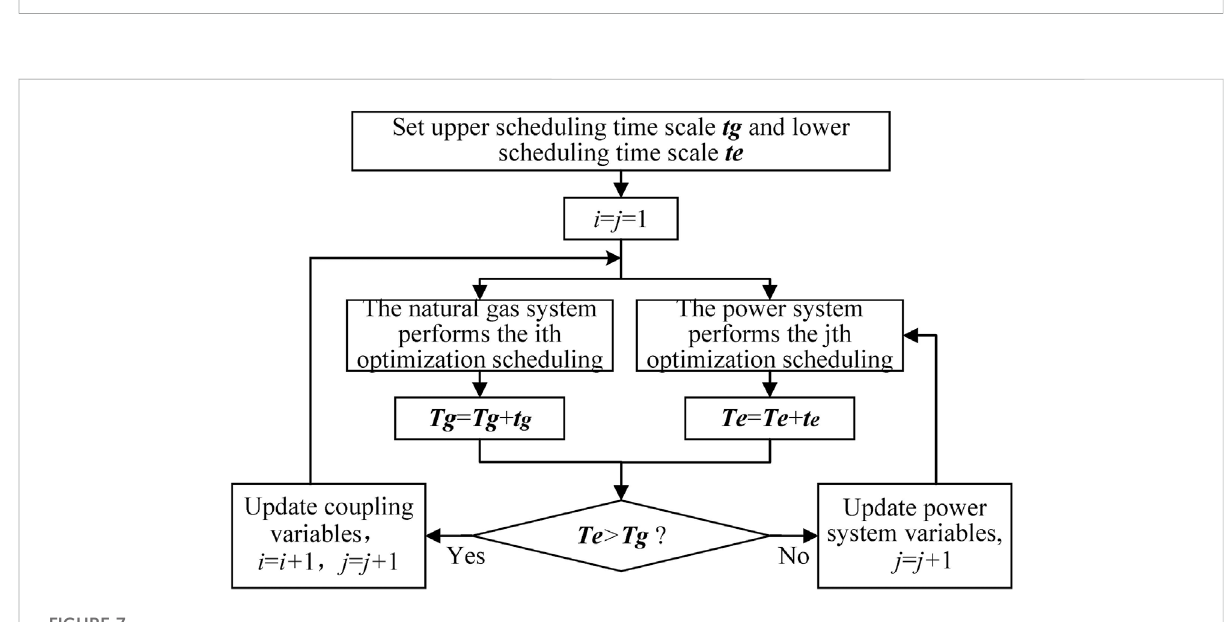
FIGURE 7 Multi-time scale optimal scheduling process of the